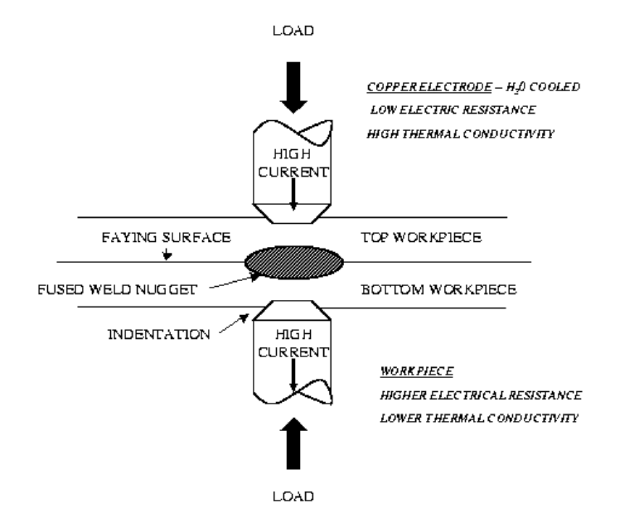
Figure 8. Schematic of the spot-welding process.